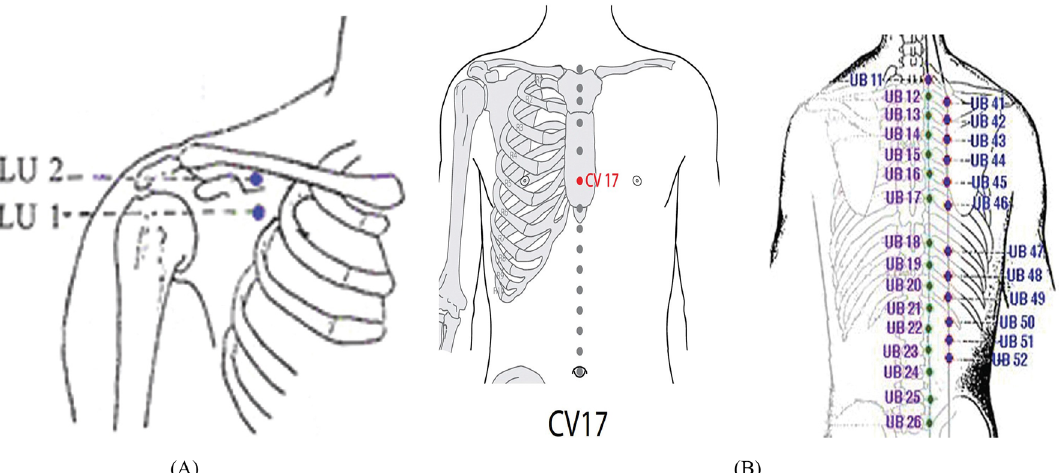
Fig. 2 A , B Low level laser acupuncture points as illustrated; laser beam emits from the probe which is directed to the acupuncture points for one to two minutes at each